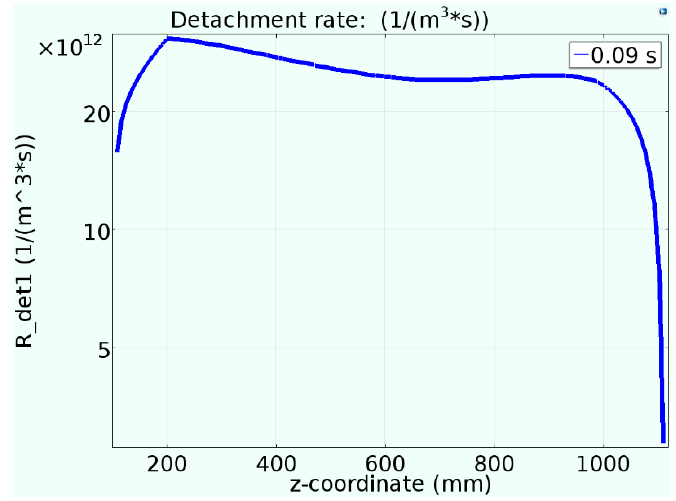
Figure 14. Detachment reaction rate at r = 100 mm at the peak stage of discharge.